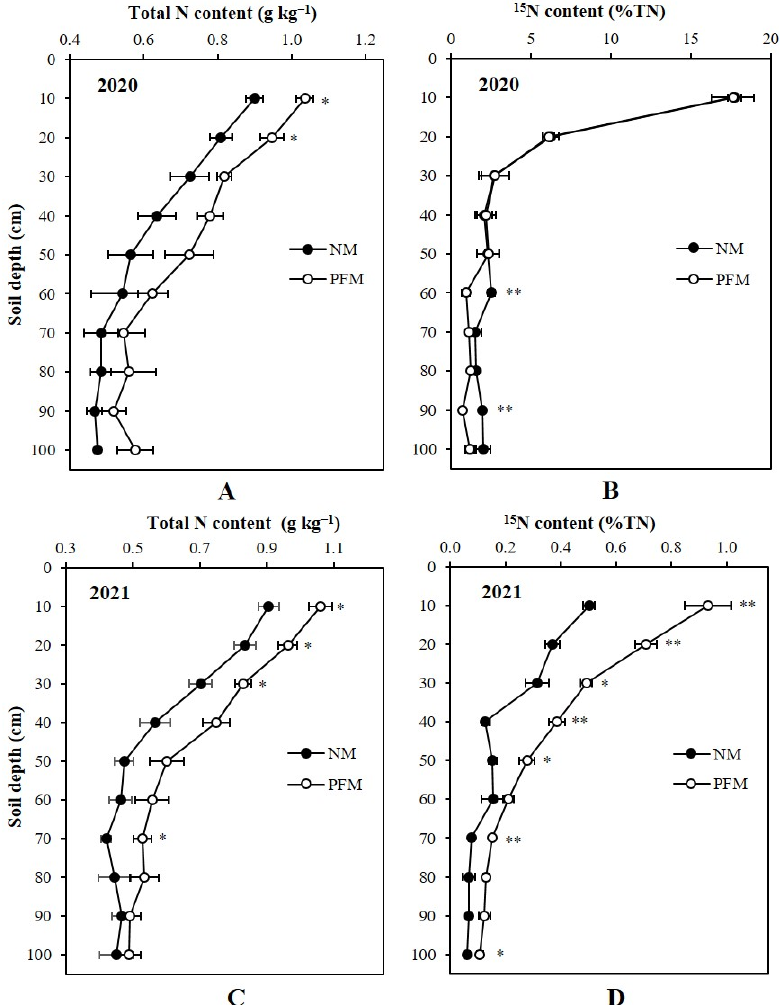
Figure 1. Effects of plastic film mulching and no-mulching treatments on the depth distribution of soil total N ( A , C ) and 15 N content ( B , D ) in the soil profile. ** Significant differences between treatments at p < 0.01, * significant differences between treatments at p < 0.05. 2020, soil sampling at final harvest of maize in 2020; 2021, soil sampling at final harvest of maize in 2021. PFM, plastic film mulching; NM, no-mulching (control).